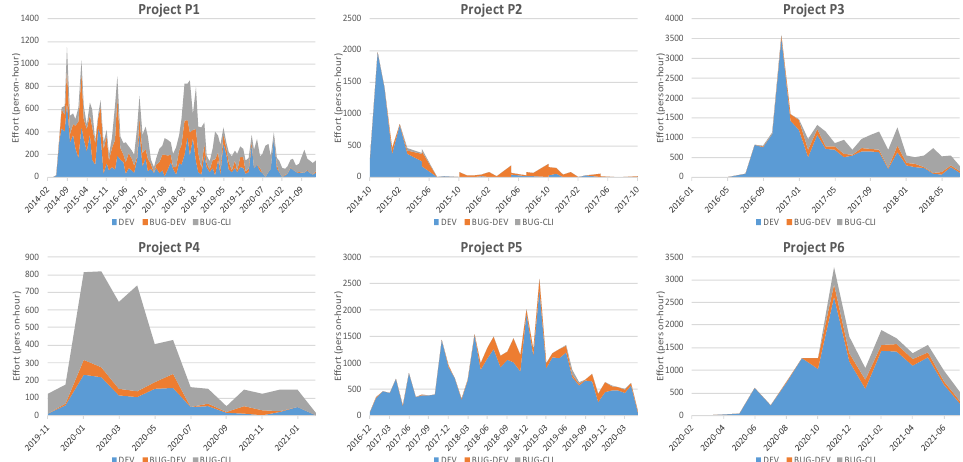
Figure 8. Stateful tasks created in the development process of the researched projects.